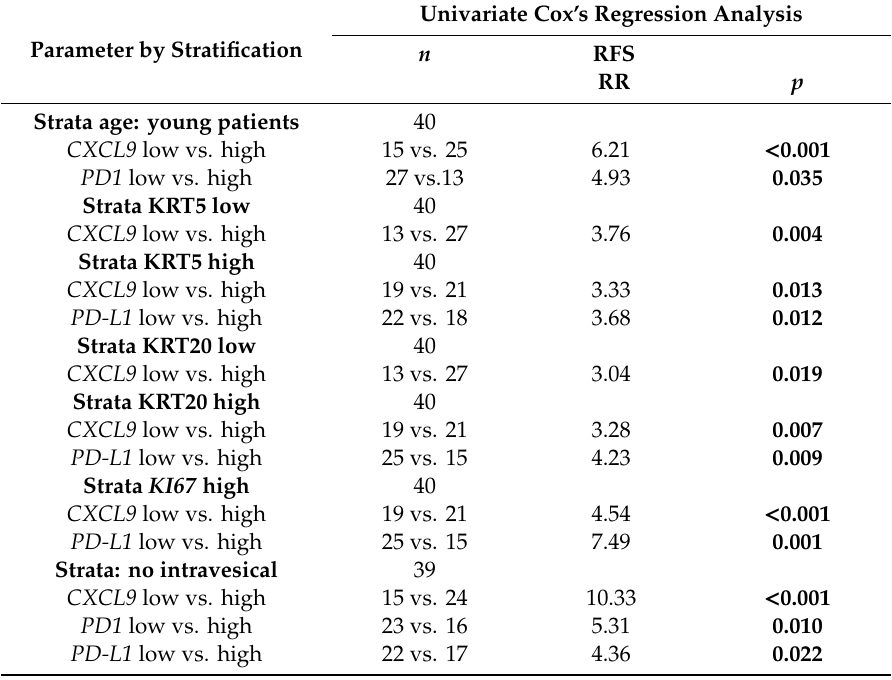
Table 5. Univariate Cox’s regression analysis for stratification by clinicopathological or molecular parameters: the association of CXCL9, PD1 and PD-L1 mRNA with